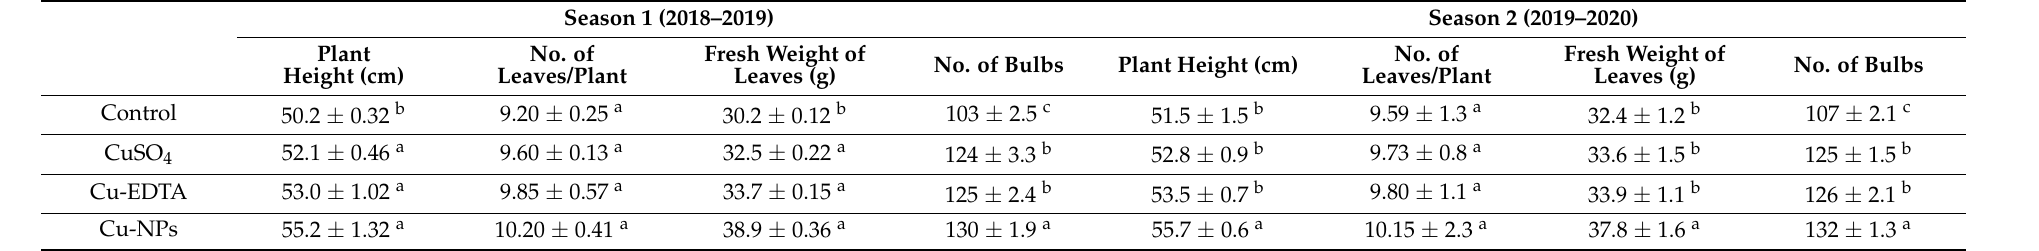
Table 4. Effects of different sources of Cu on vegetative growth parameters of onion in two seasons (2018/2019 and 2019/2020).